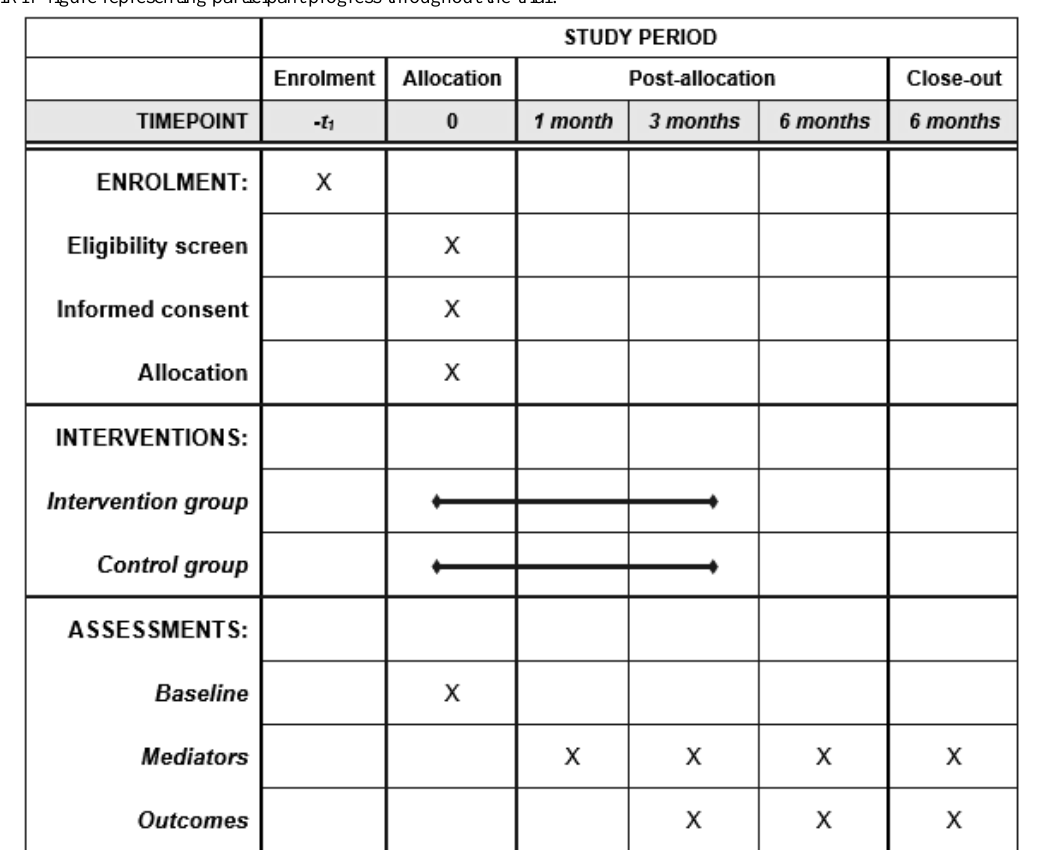
Figure 1. SPIRIT figure representing participant progress throughout the